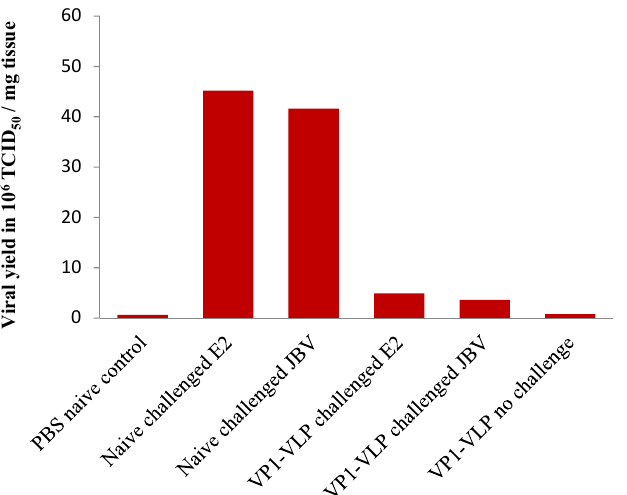
Figure 9. Viral load in the pancreas tissues of naive not challenged, naive challenged, and VP1-VLP vaccinated mice groups at day 20 after lethal CVB4E2 or CVB4JBV challenges (42 days post first immunization). Viral load (TCID 50 /mg) was determined in HeLa cells using Reed–Muench method [21]. VP1-VLP vaccinated and challenged mice groups showed a 10-fold lower viral load than the naive challenged mice groups.